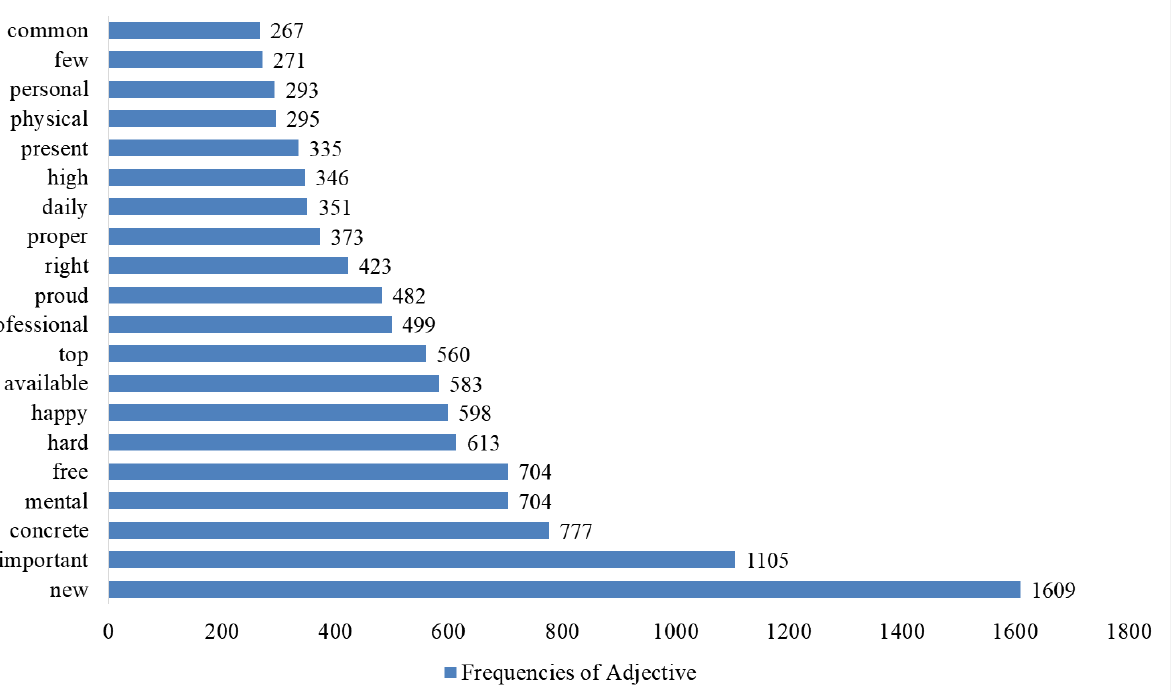
Figure 7. Tag clouds: ( a ) all sentiment, ( b ) positive sentiment, and ( c ) negative sentiment. Table 5. Source data.